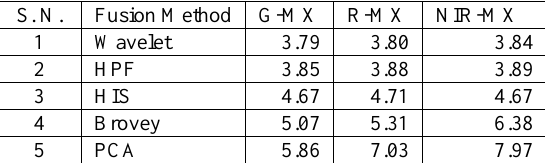
Table-2: ERGAS index for different fusion methods